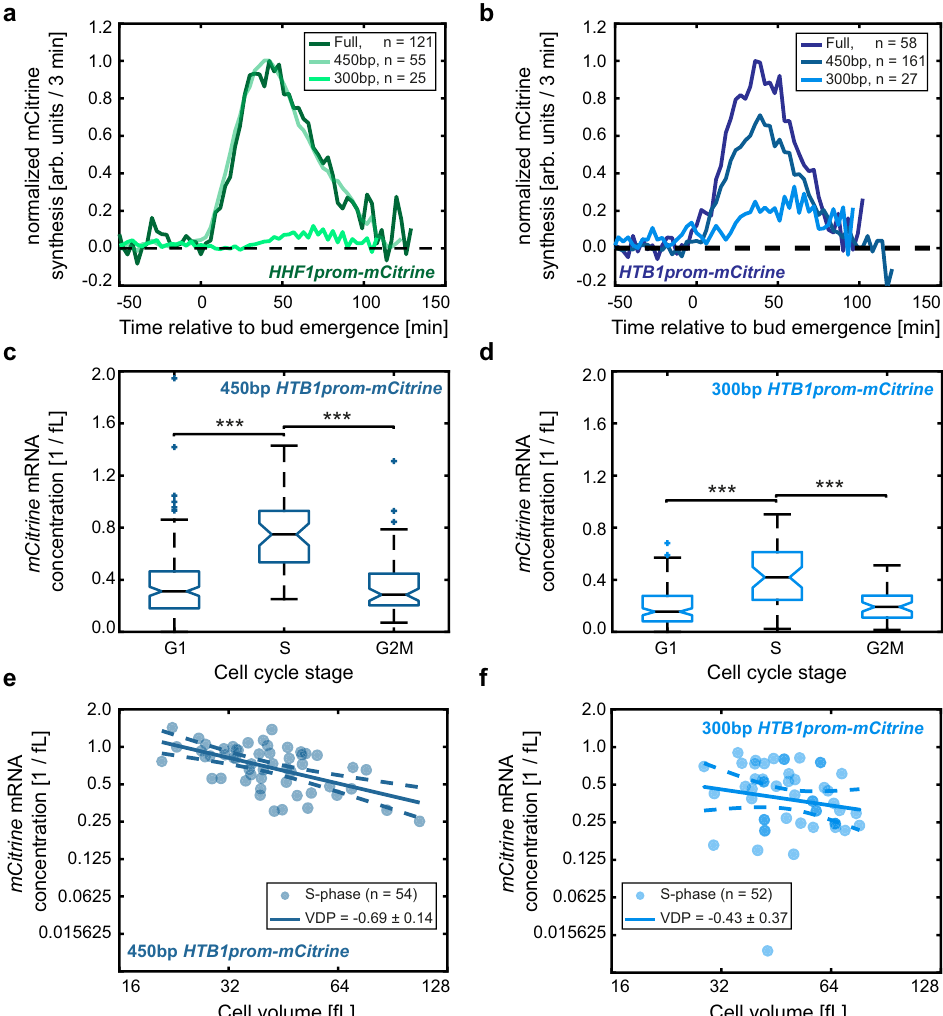
Fig. 7 Change in behavior of truncated histone promoters is not due to a disruption of the cell-cycle-dependence. a , b mCitrine synthesis rate measured by live-cell fl uorescence microscopy during the fi rst cell cycle of new-born diploid cells, when expressed from HHF1 ( a ) or HTB1 ( c ) promoter truncations. Traces represent the mean of the moving averages over three frames of the single cell traces and are shown for the time span during which at least ten single cell traces were included in the average. All traces are aligned at the time of fi rst bud emergence ( t = 0) and normalized to the maximum mean value of mCitrine synthesis for the full promoter. c , d mCitrine mRNA concentration in G1-, S-, or G2/M-phases, estimated as the number of mRNA spots detected with smFISH in the whole cell including the bud and divided by the cell volume, measured for diploid cells expressing mCitrine from an additional 450 bp ( c ) or 300 bp ( d ) HTB1 promoter truncation. Colored boxes highlight the 25- and 75-percentiles, whiskers extend to ± 2 : 7 σ of the distributions and colored crosses highlight outliers. Black, horizontal lines indicate the median between single cells for n G1 ¼ 160 ; n S ¼ 54 ; n G2M ¼ 66 ( c ) and n G1 ¼ 131 ; n S ¼ 52 ; n G2M ¼ 55 ( d ), with notches indicating the 95% con fi dence interval. Signi fi cances were tested using a Kruskal – Wallis test at a con fi dence level α ¼ 0 : 05; *** p ¼ 2 : 5 (cid:3) 10 (cid:1) 14 , *** p ¼ 2 : 9 (cid:3) 10 (cid:1) 12 ( c ), *** p ¼ 5 : 2 (cid:3) 10 (cid:1) 13 , *** p ¼ 1 : 6 (cid:3) 10 (cid:1) 8 ( d ). e , f mCitrine mRNA concentration G1vs S S vs G2M G1vs S S vs G2M in S-phase cells, expressed from an additional 450 bp ( e ) or 300 bp ( f ) HTB1 promoter truncation, shown as a function of cell volume in a double- logarithmic plot. Solid lines show linear fi ts to the double-logarithmic data, dashed lines represent the 95% con fi dence intervals of the fi t. Volume- dependence parameters (VDPs) were determined as the slope of the fi t, with respective standard